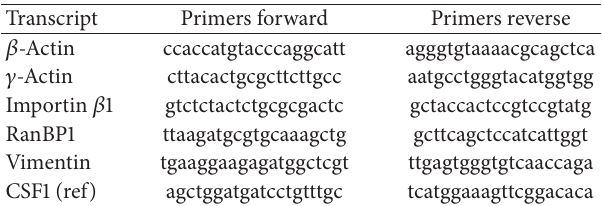
Table 1: Primer pairs for